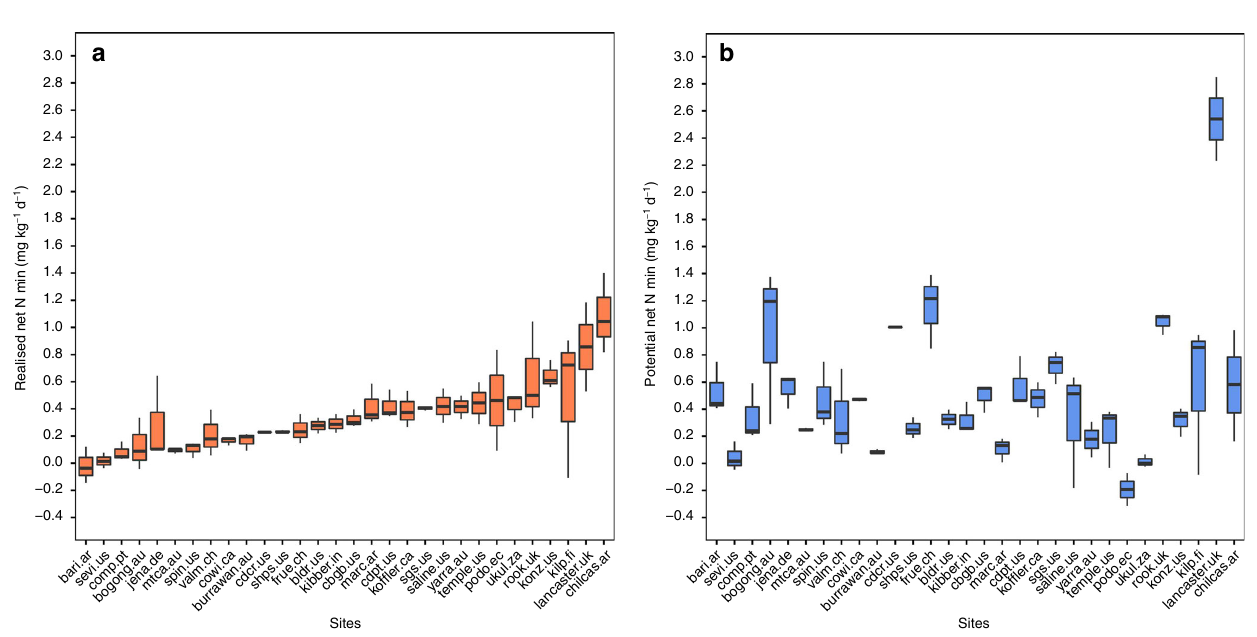
The goal of this study was to determine whether knowledge about the potential of a soil to mineralise N can predict realised N min, but we only found a weak correlation between potential and realised N min (see main text, Supplementary Figure 1). However, the potential of soil microbes to mineralise N may be revealed when we include several climatic as well as soil biotic and abiotic predictors simultaneously into a model as done here. Thus, higher potential N min measured in the laboratory should result in higher realised N min in the fi eld across global grasslands.